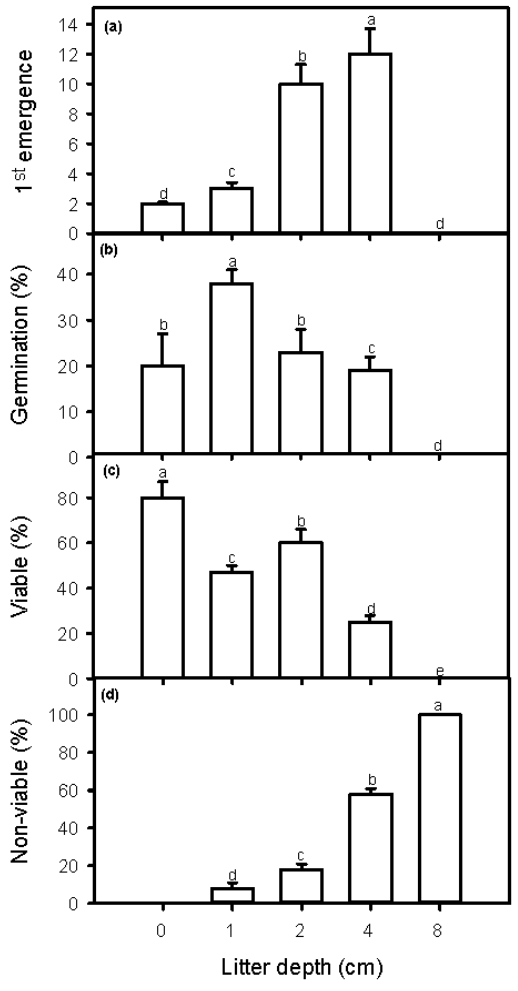
Figure 2. Days to first germination ( a ), germination percentage ( b ), and percentages of viable ( c ) and non-viable ( d ) seeds of Prosopis julflora for the five leaf litter depth treatments under field conditions. The value of germination percentage, present viable seeds, and percentage of non-viable seeds sums to 100% for each litter depth. Different letters indicate significant differences between treatments (ANOVA, p < 0.05).